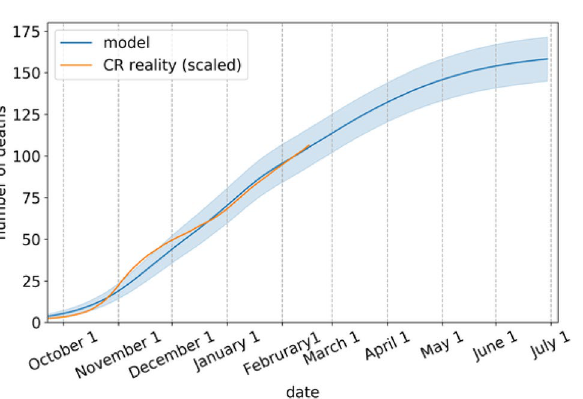
Figure 1. Model H calibration results performed via the Approximate Bayesian Computation technique. The top left panel: proportional reduction of contacts due to COVID-19-related interventions in Czechia; since March 1, 2021, contacts are set at 45% outside schools and 1% in schools. The top right and bottom left panels: while thin lines correspond to the best 20 worlds out of 100.000 simulated ones (selected on the basis of the smallest Euclidean distance between the simulated and observed data), thick dashed lines are respective mean model trajectories. While the thick solid lines are real data up to February 15, 2021, that is, data used for calibration, the black lines are data after that date, providing sound model validation. The bottom right panel: daily numbers of the first vaccine doses administered among the considered age cohorts with 21-day delay.